Question: Condense the content of this figure into a single sentence.
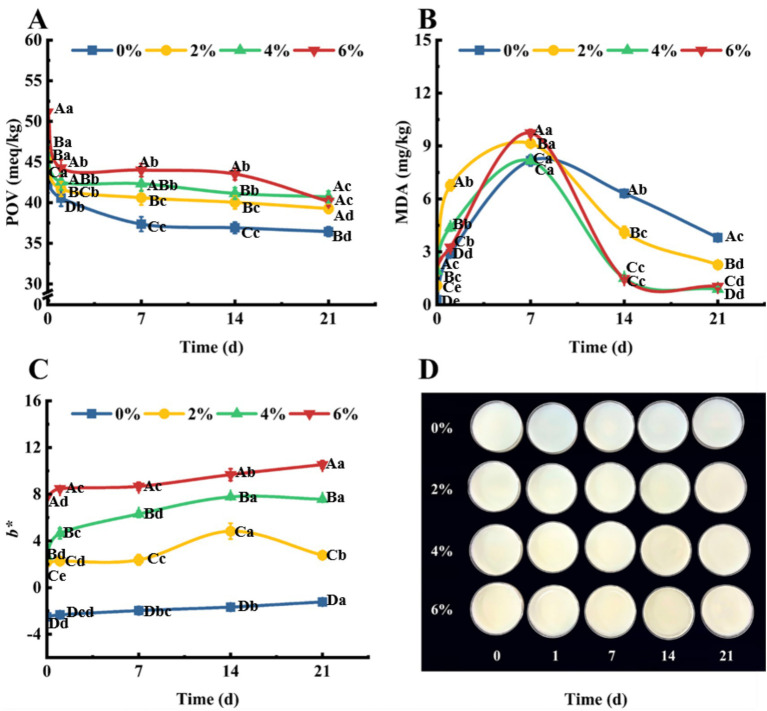
Answer: Contents of POV (A) and MDA (B) , b* (C) and image of storage milk (D) in 4 groups milk (0, 2, 4 and 6% milk fat) during storage at 4 °C for 21 days ( n = 3). Uppercase letters represented the differences of four groups; lowercase letters represented the difference of the same group at different storage time.